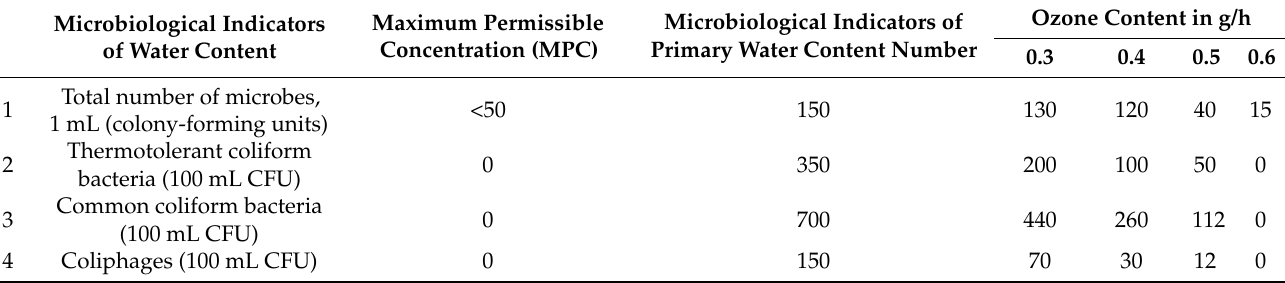
Table 3. Microbiological indicators of water content in the